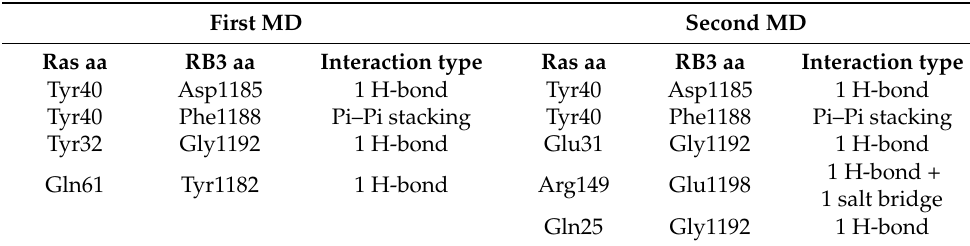
Table 4. The most stable interactions between Ras and the RB3 peptide highlighted from the MD trajectory